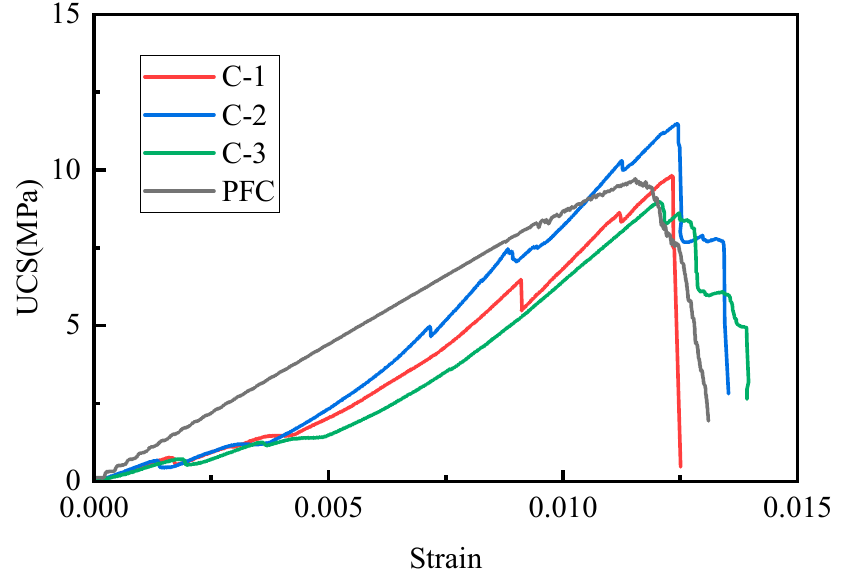
Figure 4. Coal and numerical model stress–strain curve. Table 3. Micromechanical parameters of coal.